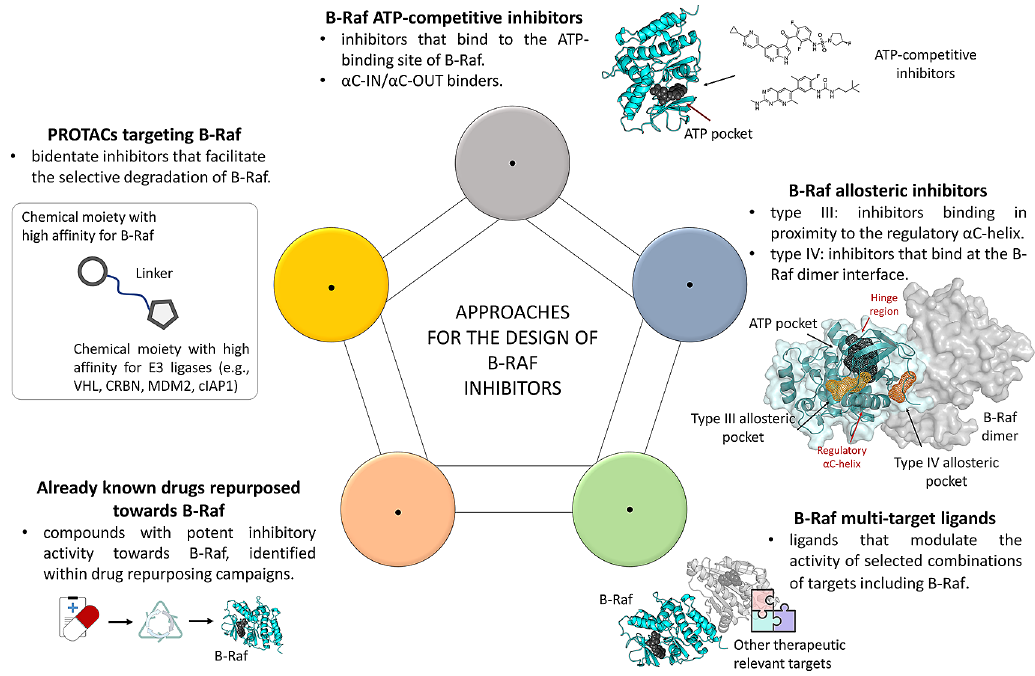
Figure 1. Schematic representation of the approaches currently pursued for the design of B-Raf ligands, discussed in the